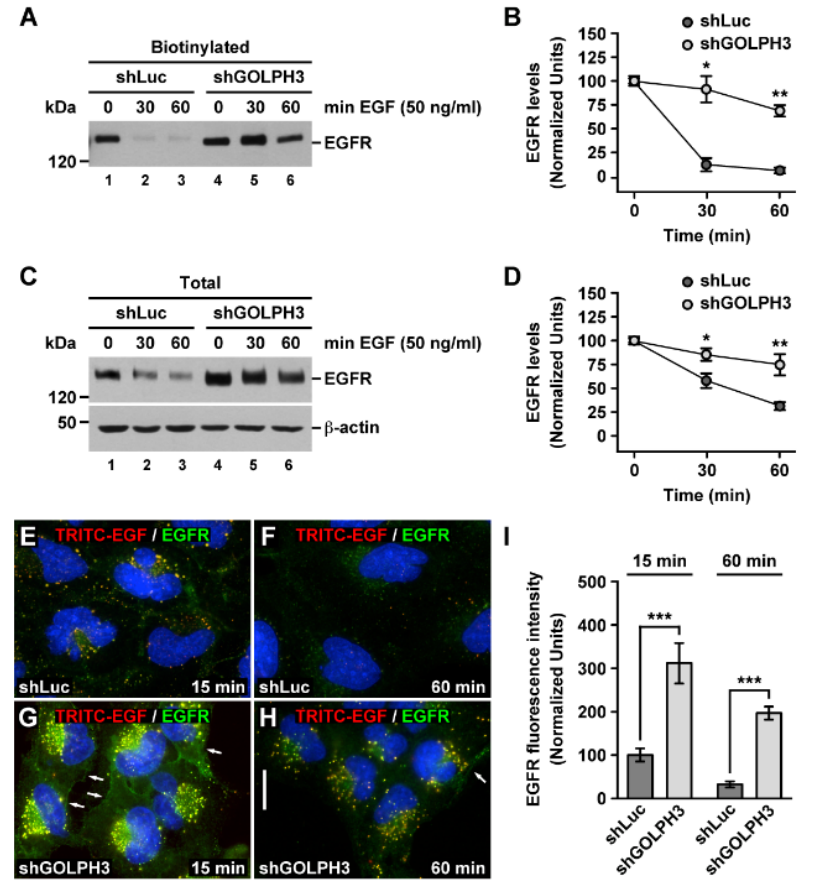
Figure 6. The knockdown of GOLPH3 impairs ligand-induced internalization and degradation of EGFR in T98G cells. ( A , C ) The indicated cells grown in 6-well plates were incubated with EGF for the indicated periods of time. Cells were subjected to cell surface biotinylation, and after the preparation of detergent-soluble extracts, biotinylated proteins were pulled down with Neutravidin-Agarose. Samples from biotinylated proteins (A; Biotinylated) or from the total detergent-soluble extracts (C; Total) were analyzed by SDS-PAGE followed by immunoblotting using antibodies to detect the proteins indicated on the right. The immunoblot signal of anti- β -actin was used as the loading control. The position of molecular mass markers is indicated on the left. ( B , D ) Densitometry quantification of the immunoblot signal of the biotinylated or total levels of EGFR as shown in A and C. Graphs depict the mean ± standard deviation ( n = 3; * p < 0.05; ** p < 0.01). ( E – H ) The indicated cells grown in glass coverslips were incubated for the indicated periods of time with EGF conjugated to tetramethylrhodamine B isothiocyanate (TRITC-EGF; red channel). Cells were fixed, permeabilized, and labeled with sheep polyclonal antibody to EGFR followed by incubation with Alexa-488-conjugated donkey anti-sheep IgG (green channel), and nuclei were stained with DAPI (blue channel). Stained cells were examined by fluorescence microscopy. Images represent the merging of red, green, and blue channels. Yellow indicates the overlapping localization of the red and green channels. Arrows indicate the localization of EGFR at the cell surface. Bar, 10 µ m. ( I ) Quantification of the fluorescence intensity signal of the detection of EGFR as shown in E–H. Bars represent the mean ± standard deviation ( n = 20; *** p <